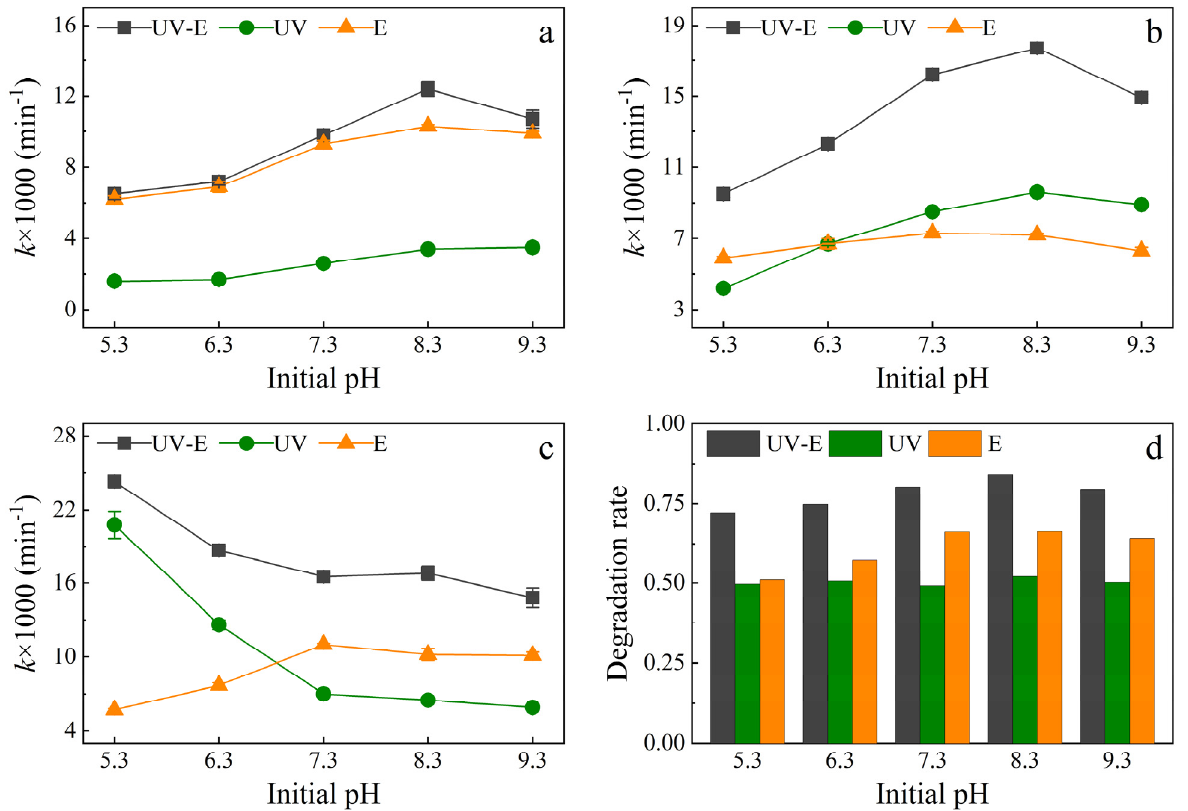
Figure 5. Effect of different initial pH on sulfonamide degradation. Conditions: Cl − concentration of 50 mg/L, no aeration, UV power of 48 W, current of 1.8 A (4.8 mA/cm 2 ), and initial pH of 8.3. UV-E: UV irradiation and electrolysis, UV: UV irradiation only, and E: electrolysis only. The k values for ( a ) SMZ, ( b ) SMM, and ( c ) SMX. ( d ) The total degradation rate in the different systems.